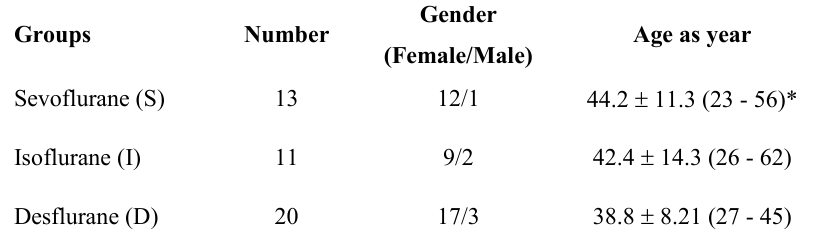
Table 1. Demographic data of the patients. *Mean value ± standard deviation (minimum -